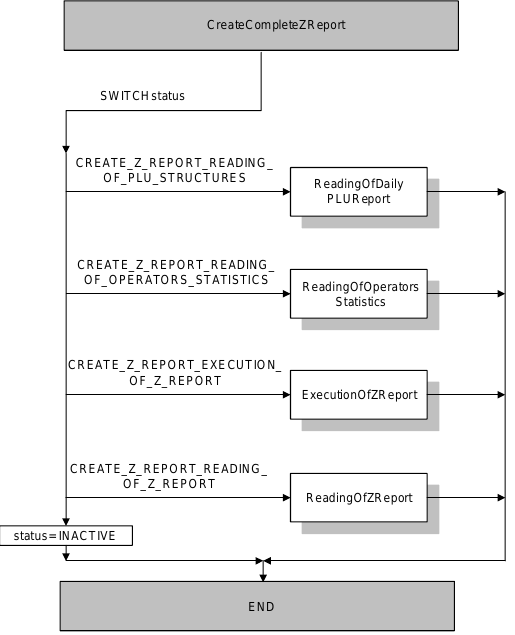
Figure 11. CreateCompletZReport subprogram algorithm.